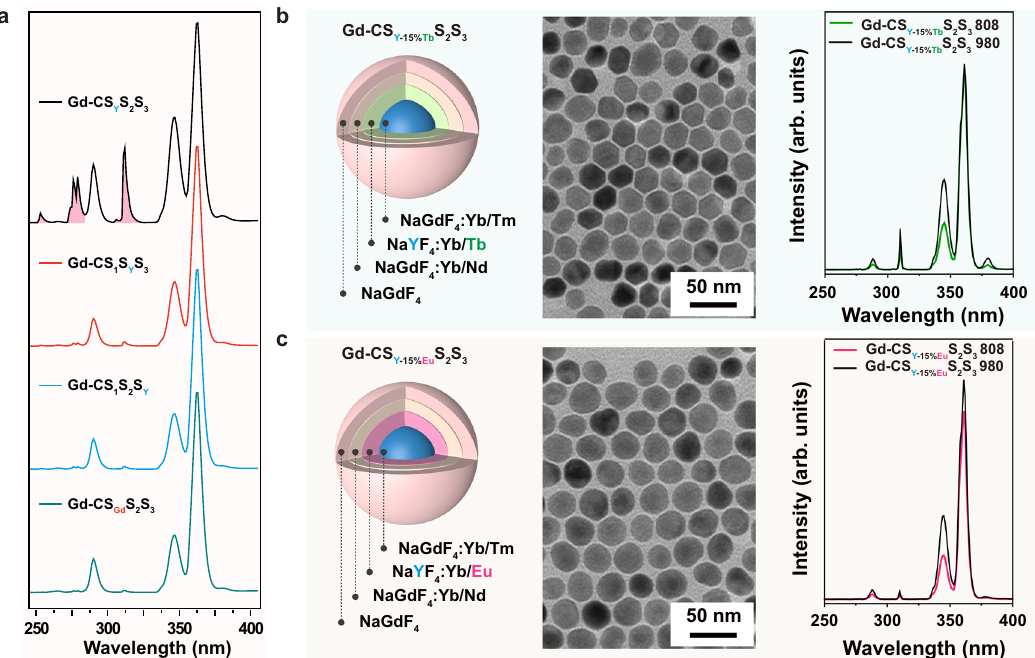
Fig. 6 Characterization of core-multishell nanoparticles with alternative dopants and structural layouts. a Room-temperature upconversion emission spectra of solutions containing Gd-CS Y S 2 S 3 , Gd-CS 1 S Y S 3 , Gd-CS 1 S 2 S Y , and Gd-CS Gd S 2 S 3 nanoparticles under 808 nm excitation at a power density of 10 W cm − 2 . b, c Schematic illustration, TEM images and photoluminescence spectra of the as-synthesized Gd-CS Y-15%Tb S 2 S 3 and Gd-CS Y-15% Eu S 2 S 3